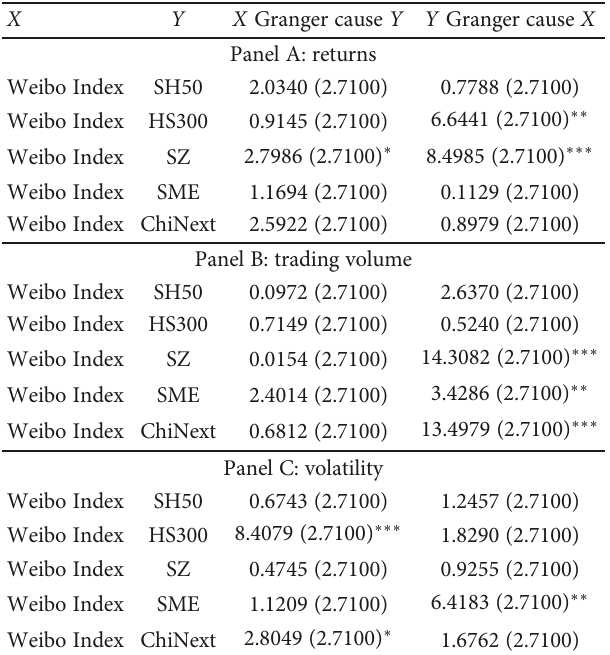
This table reports the results for the Granger causality analysis between returns, trading volume, and volatility of SH50, HS300, SZ, SME, and ChiNext and Weibo attention. The X Granger cause Y means Weibo attention can Granger-cause the changes of market variables and Y Granger cause X means markets can Granger-cause the changes of Weibo attention. ∗∗∗ indicates signi fi cant at 1% level; ∗∗ indicates signi fi cant at 5% level; ∗ indicates signi fi cant at 10%